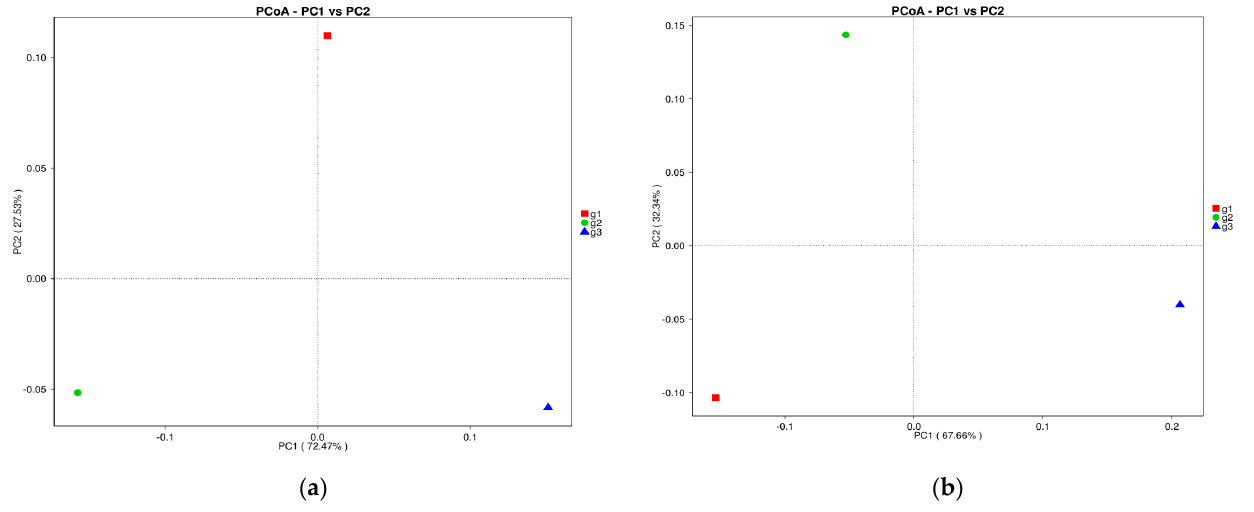
Figure 5. Differences between microbial communities revealed by principal coordinates analysis (PCoA): ( a ) PCoA based on weighted UniFrac distance; ( b ) PCoA based on unweighted UniFrac distance.